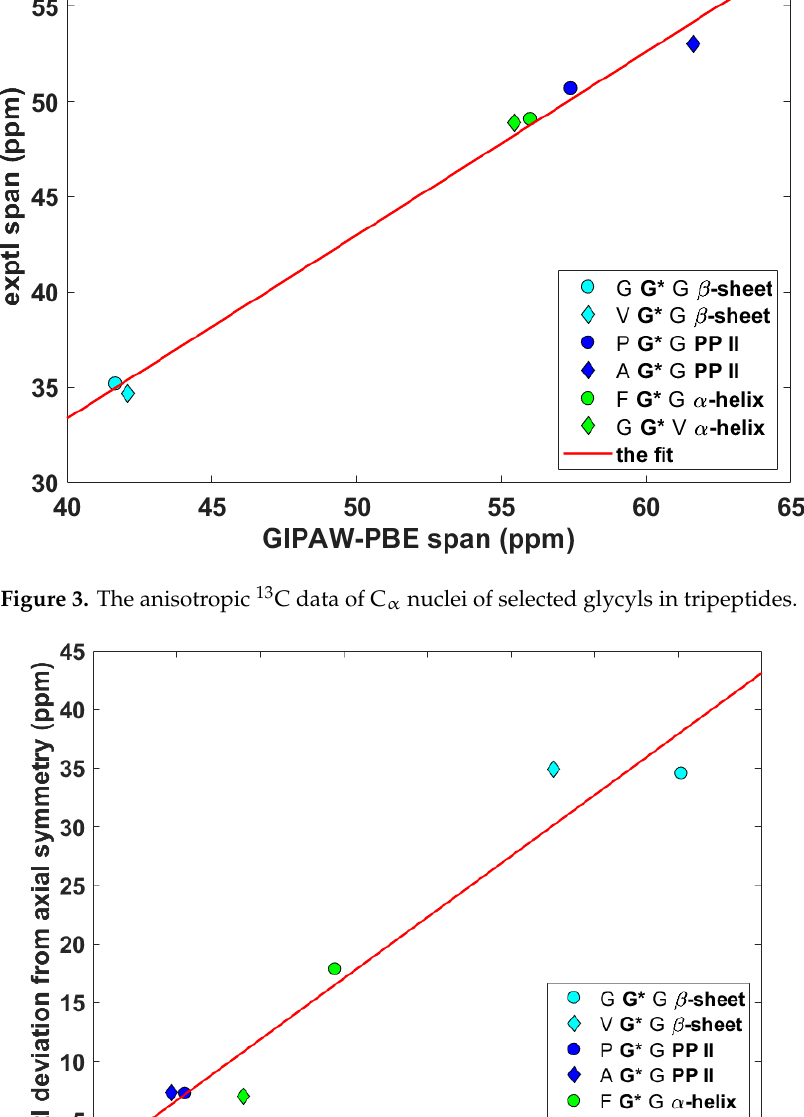
Figure 2. The isotropic 13 C data of C α nuclei of selected glycyls in tripeptides.